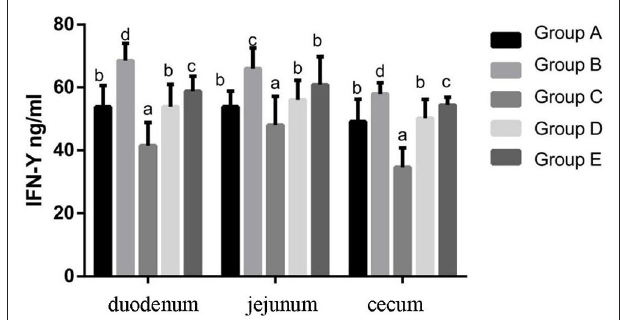
FIGURE 8 | IFN- γ contents of duodenum, jejunum and cecum in different treatment groups. Group A, control group; Group B, infection group; Group C, JYBR-190 pre-fed group; Group D, JYBR-190 fed group; Group E, antibiotic group. Data are expressed as mean ± standard deviation (SD). Different lowercase letters on the columns indicate significant differences ( P < 0.05); the same lowercase letters indicate no significant difference ( P > 0.05).